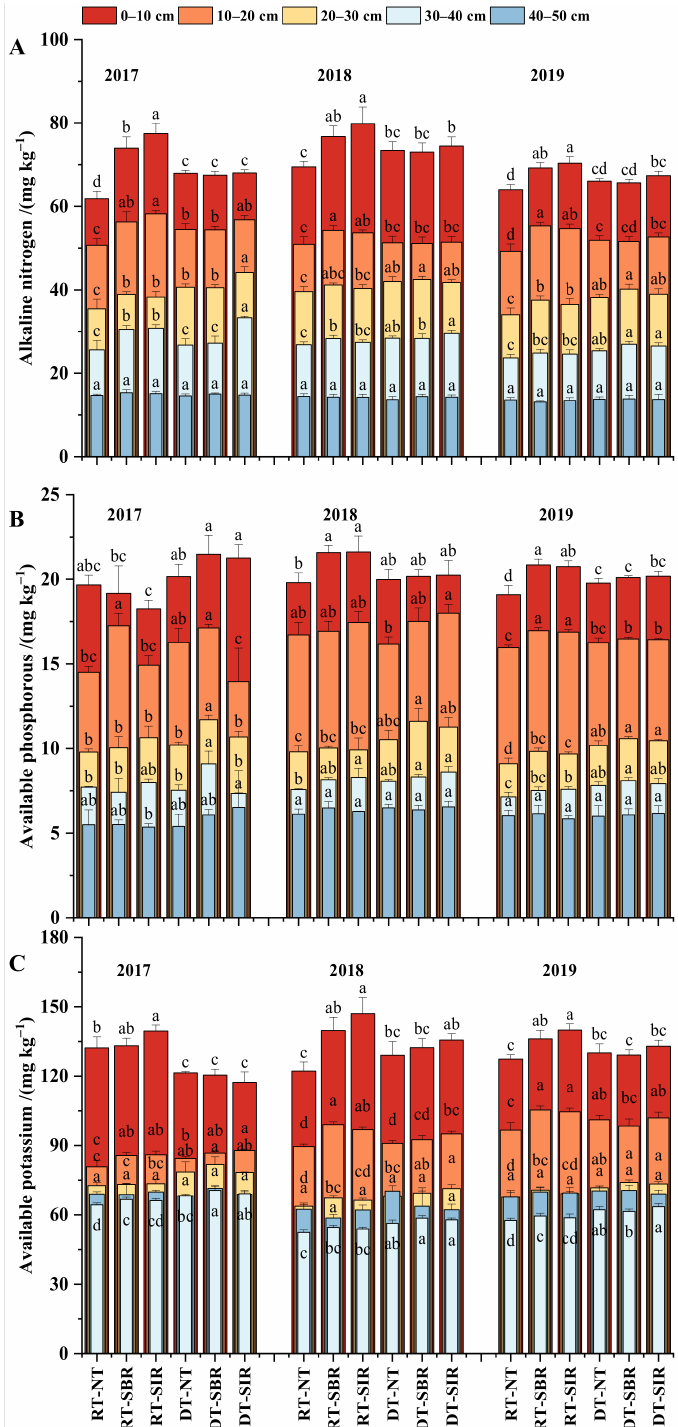
Figure 2. Soil alkaline nitrogen ( A ), available phosphorous ( B ), and available potassium ( C ) under different treatments from 2017 to 2019 during the experiment. Bars represent standard error. Different lowercase letters above the bars represent significant differences among treatments ( p <